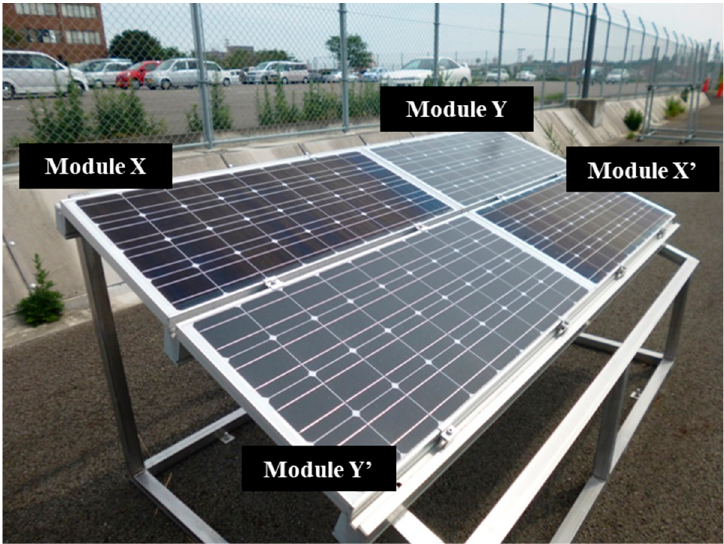
Figure 4. The surface of silicon PV modules. The two modules were coated (modules X and X ’) and the other two modules were not coated to act as references (modules Y and Y